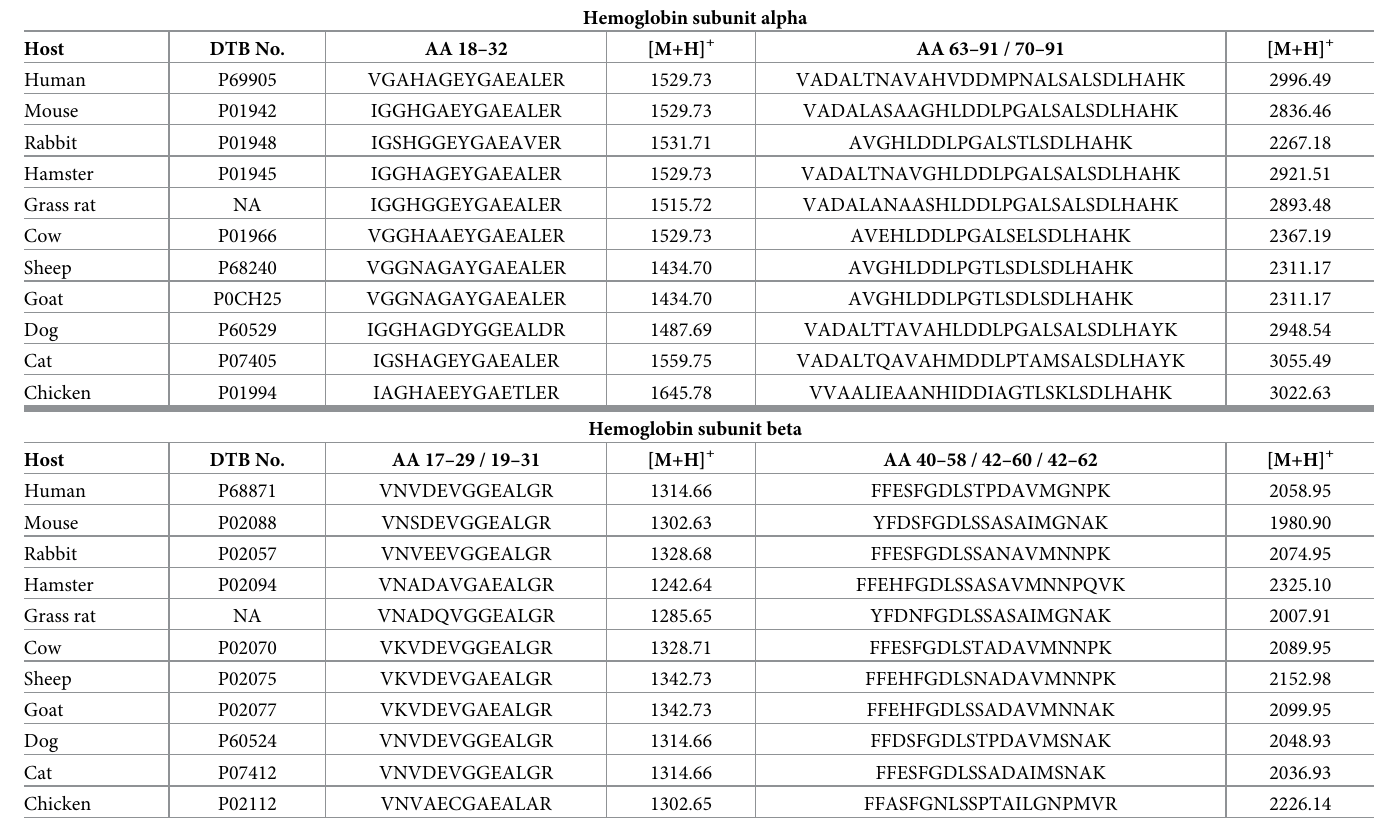
Table 1. Unique tryptic peptides of host hemoglobins used for blood meal source identification using PMM-based MALDI-TOF mass spectrometry. Hemoglobin subunit